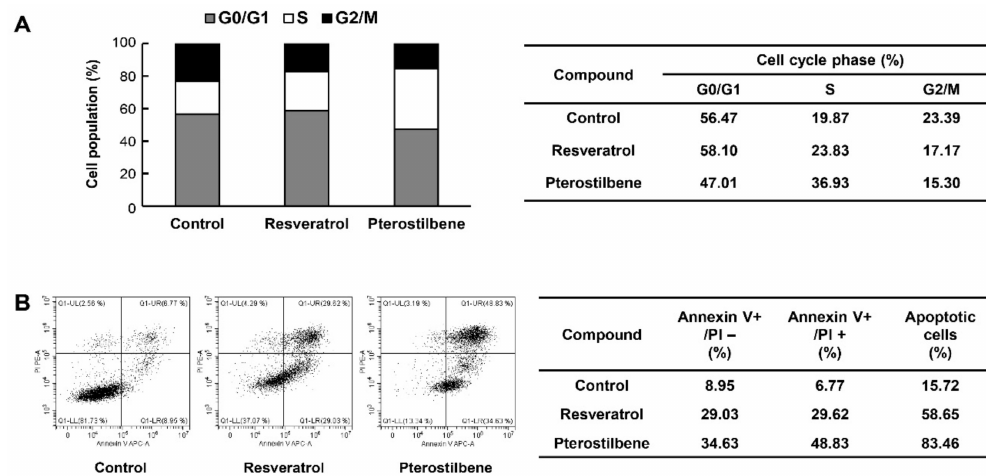
Figure 7. E ff ects of resveratrol and pterostilbene on the cell cycle and apoptotic cell death of cervical CSCs. ( A ) The cell cycle progression and ( B ) cellular apoptosis of HeLa cancer stem-like cells were measured by flow cytometry analysis after the treatment of resveratrol and pterostilbene (40 µ M) for 48 h.